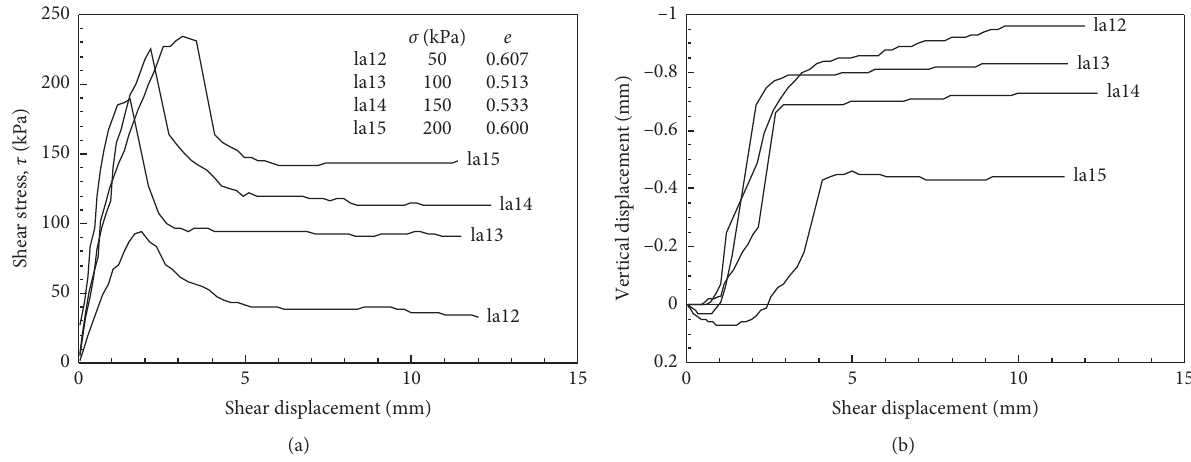
Figure 10: Data of the laboratory tests in dry condition. (a) Shear stress versus shear displacement. (b) Vertical displacement versus shear displacement.